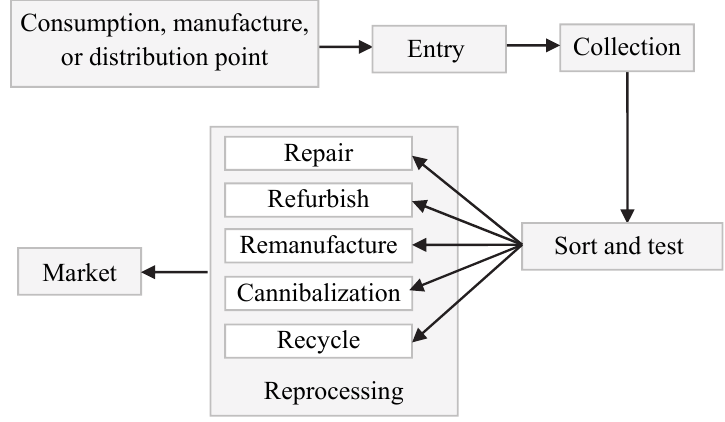
Fig. 1. General schema of